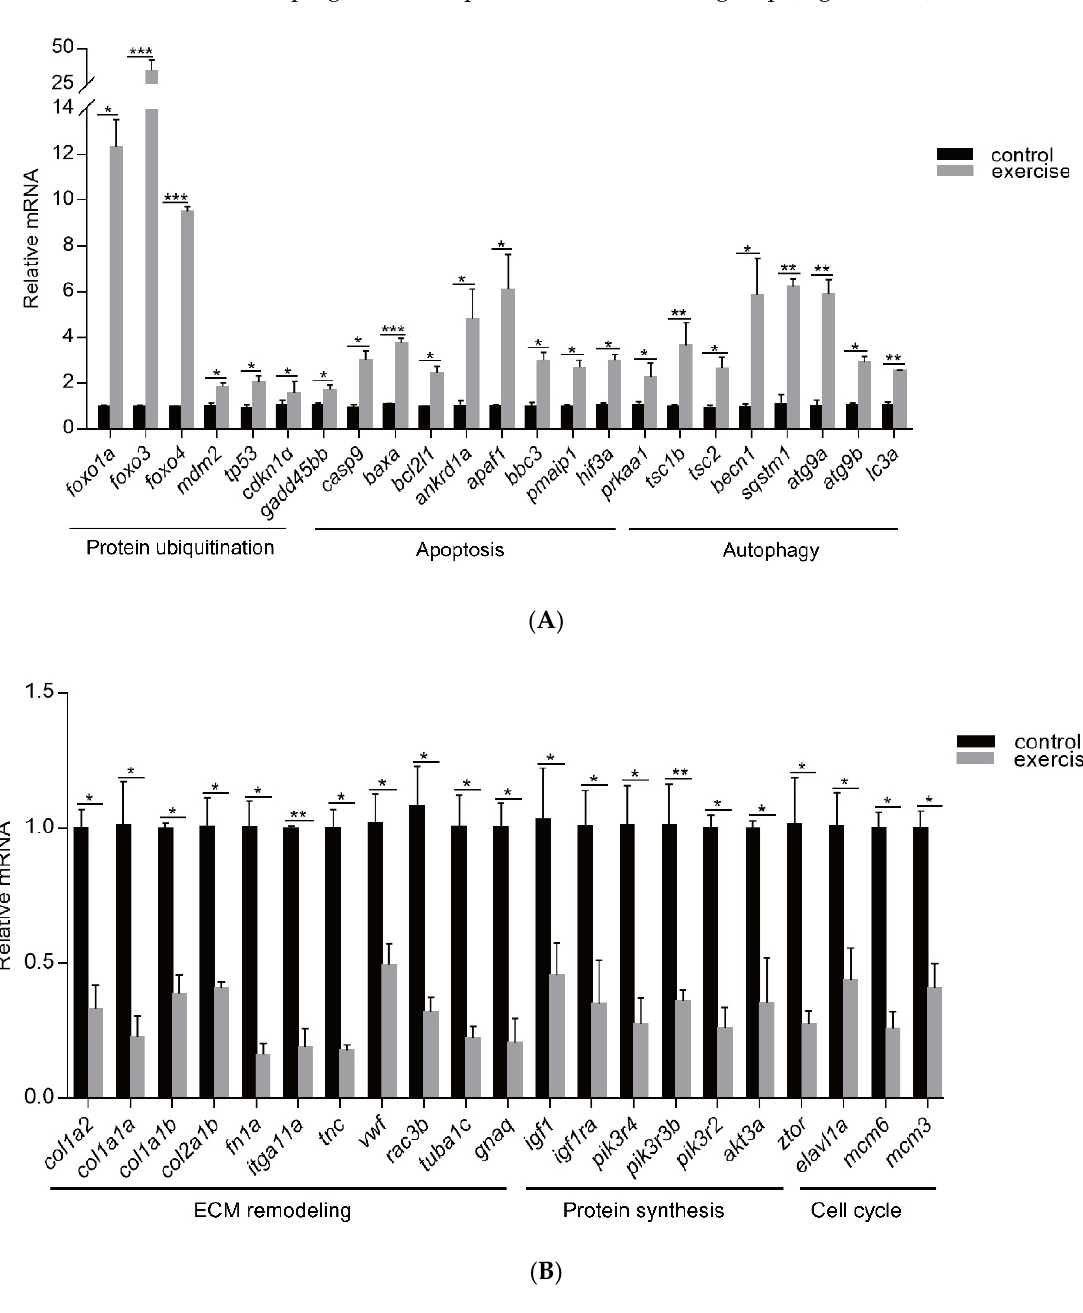
Figure 4. qRT-PCR was used to quantify key genes related to muscle atrophy caused by excessive exercise. ( A ) Upregulated genes. ( B ) Downregulated genes. The data represent mean ± SD ( n = 6). * p < 0.05, ** p < 0.01, and *** p < 0.001.